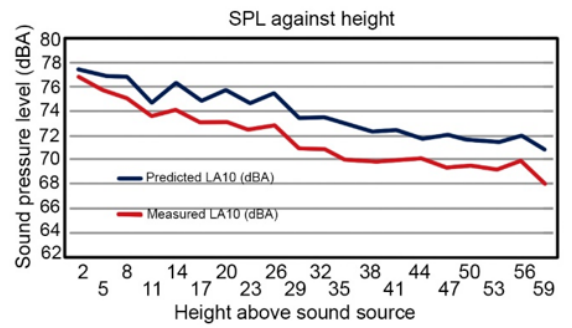
Figure 4: Comparison of the measured and predicted L A 10 values against the height of the assessment point in meters above the source, (figure taken out of